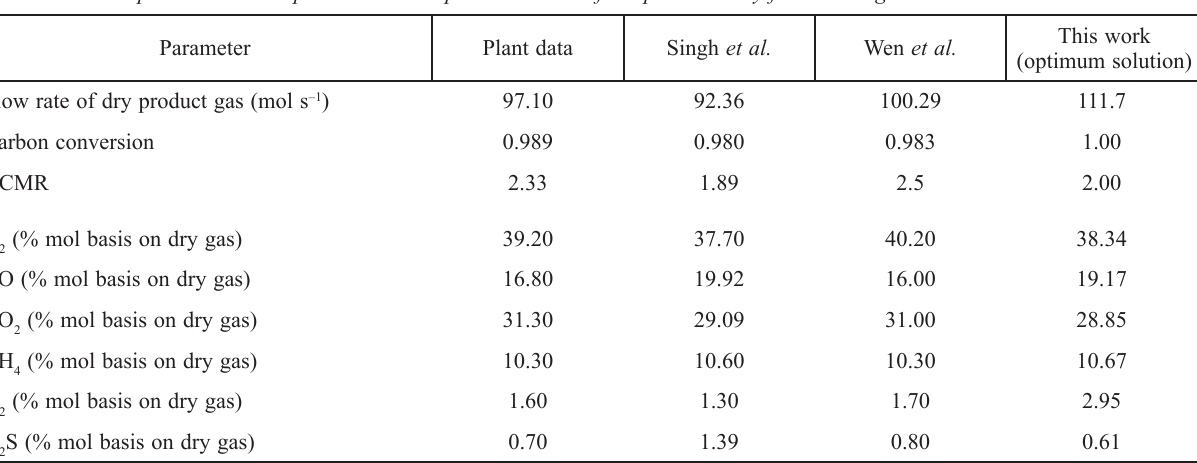
Table 5 – Comparison between plant data and optimum results of the present study for Pittsburgh No. 8 coal